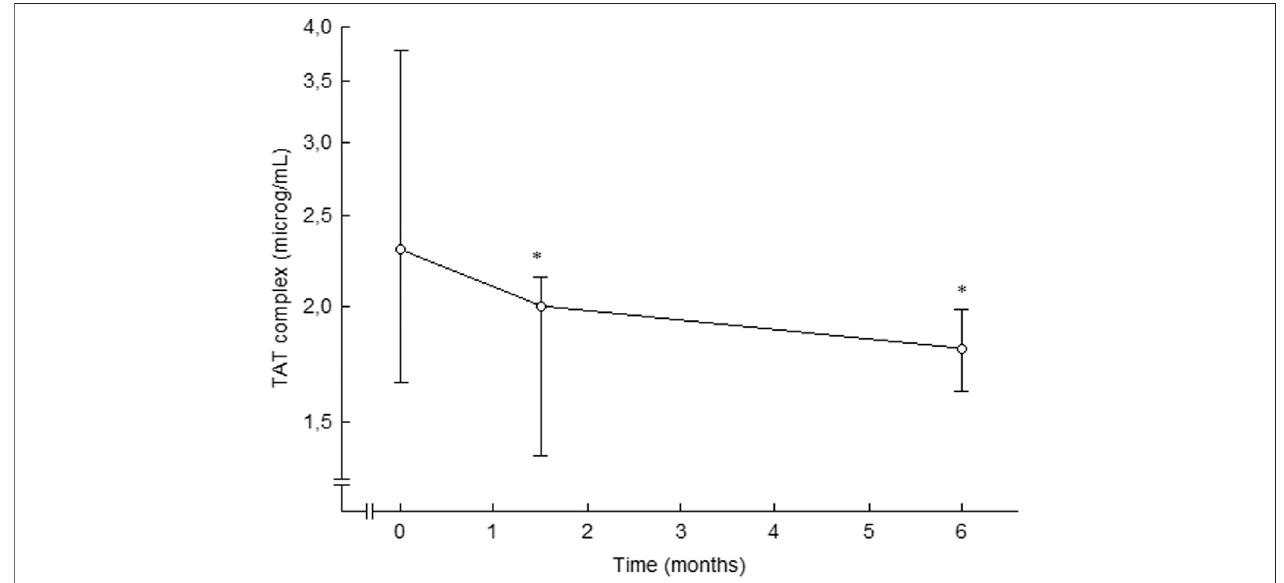
FIGURE 5 | Plasma levels of TAT complex in patients with essential hypertension during placebo (0 months) and after 6 weeks and 6 months of ramipril therapy. Data are presented as median and interquartile ranges, n (cid:1) 15. Statistical evaluation was made by non-parametric test, Wilcoxon sign test. Signi fi cant differences are given as; * p < 0.05, compared to placebo. TAT, thrombin-antithrombin. From (Ekholm et al., 2002).